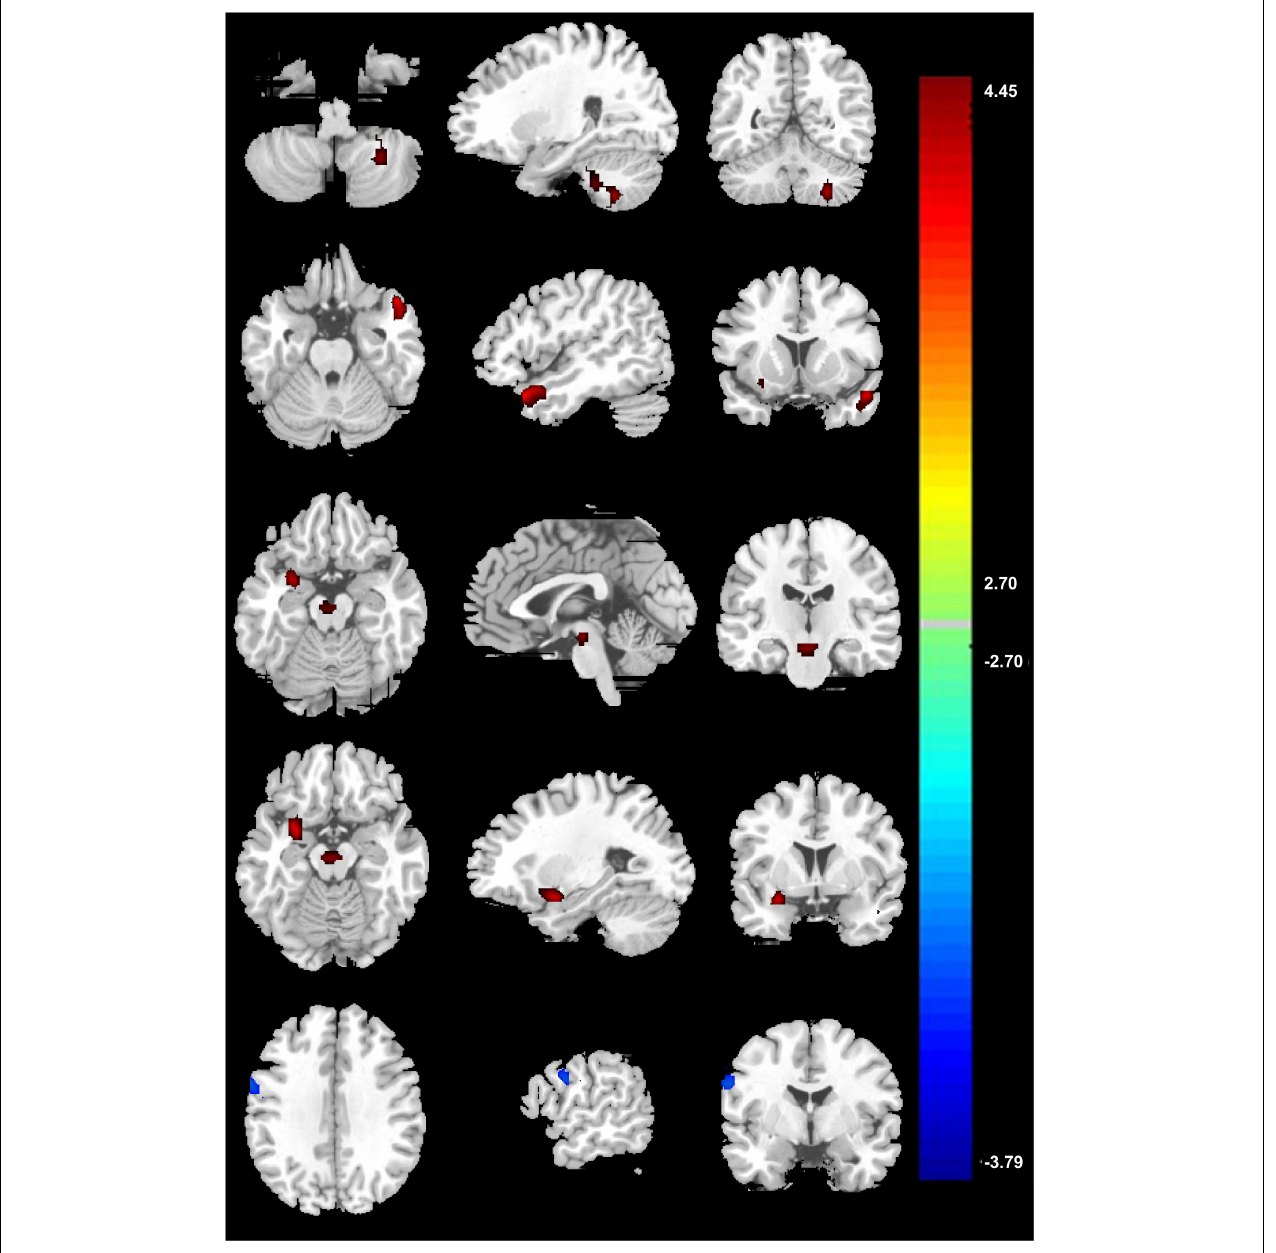
FIGURE 2 | Two-sample result between PCCPs and novices ( P < 0.05, AlphaSim corrected, a combined threshold of P < 0.005, and a minimum cluster size of 46 voxels). Hot and cold colors indicate ReHo increases and decreases in PCCPs, respectively, and the number indicates the t- value. The left and right sides in this figure correspond to the right and left sides of the brain, respectively. Further details of these regions are presented in Table 1